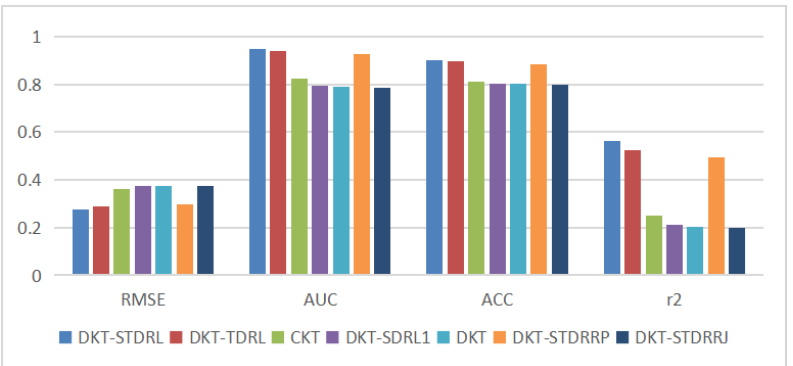
Figure 7. Prediction results of DKT-STDRL, CKT, DKT, and the variants of DKT-STDRL on the Statics2011